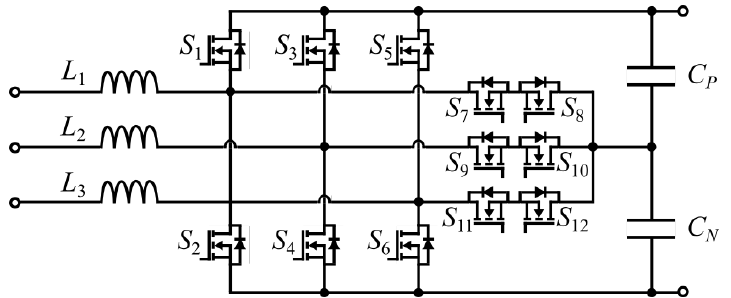
Figure 15. Three-phase three-level T-type